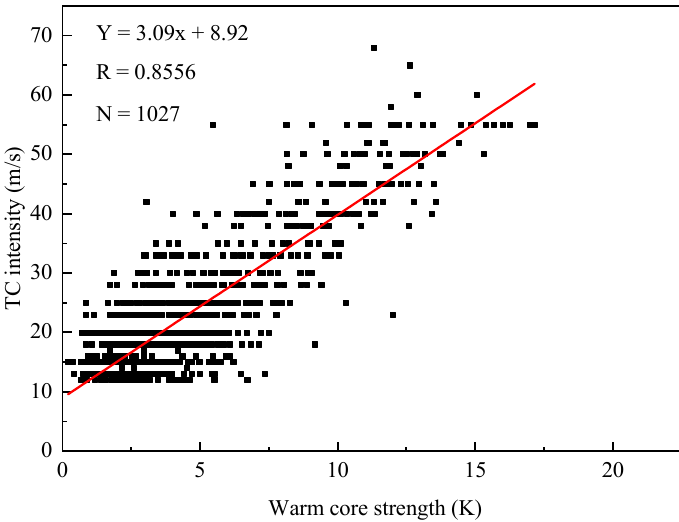
Figure 2. Scatter plot of warm core strength and TC intensity with linear fit (red line).